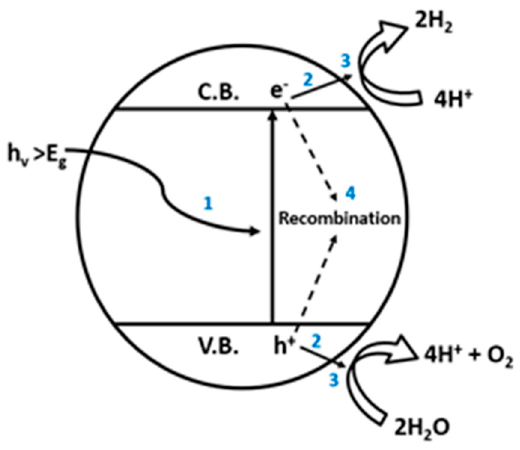
Figure 2. Schematic representation of photocatalytic water splitting with (1) light absorption and charge excitation from the valence band to the conduction band, (2) the transfer of the photogenerated electrons and holes to the catalyst surface, (3) surface redox reactions, and (4) a charge recombination. (VB valence band, CB: conductance band, and TR: trapped).